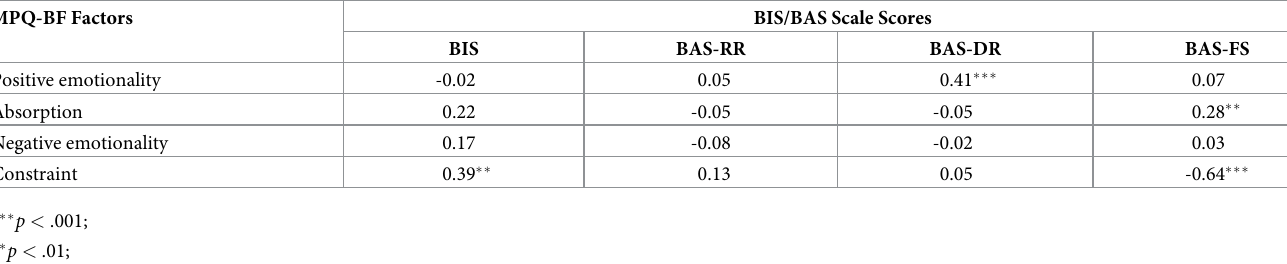
Table 3. Correlations of the ESEM MPQ-BF factors with the BIS/BAS scale